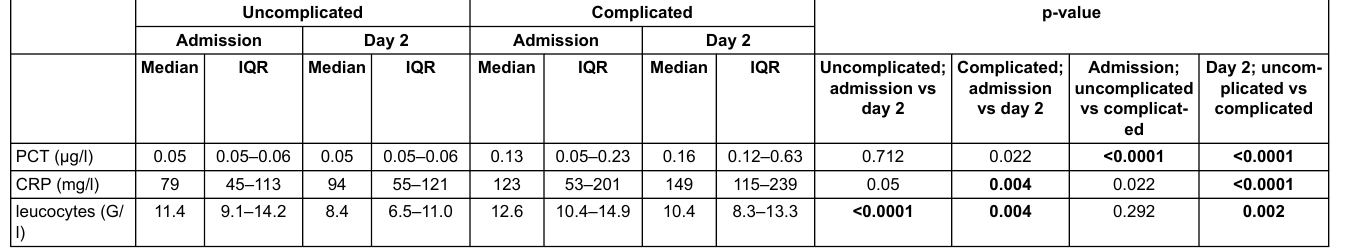
Table 2: Procalcitonin, C-reactive protein and leucocyte count on admission (day 1) and day 2.